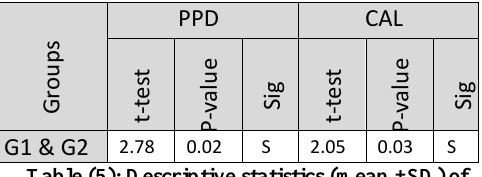
Table (5): Descriptive statistics (mean ±SD) of salivary flow rate and salivary pH in control and test group.